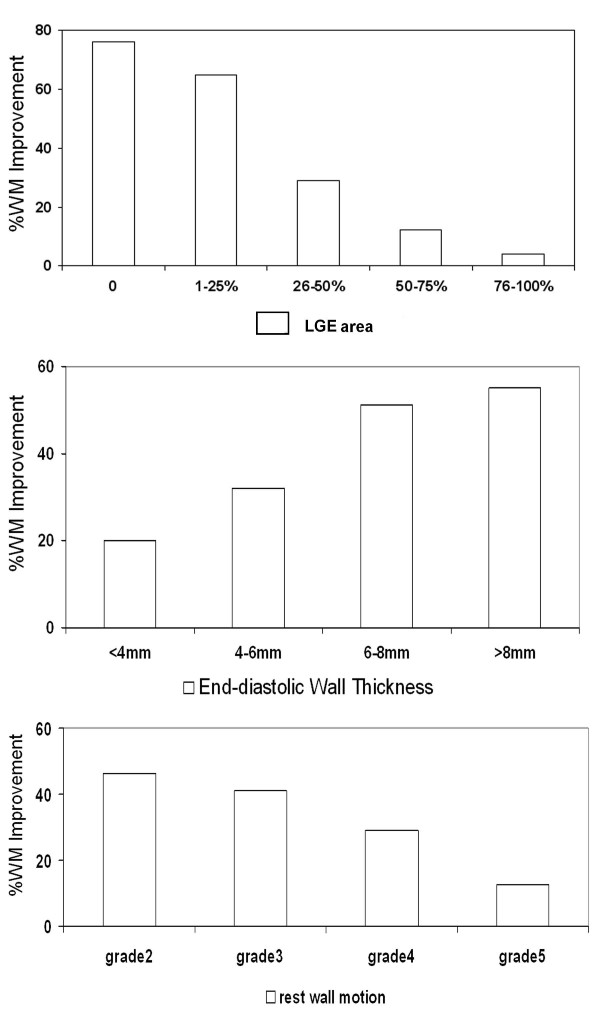
Relation of wall motion improvement and LGE area (upper), end-diastolic wall thickness (middle) and resting wall motion (lower)(WM = wall motion).